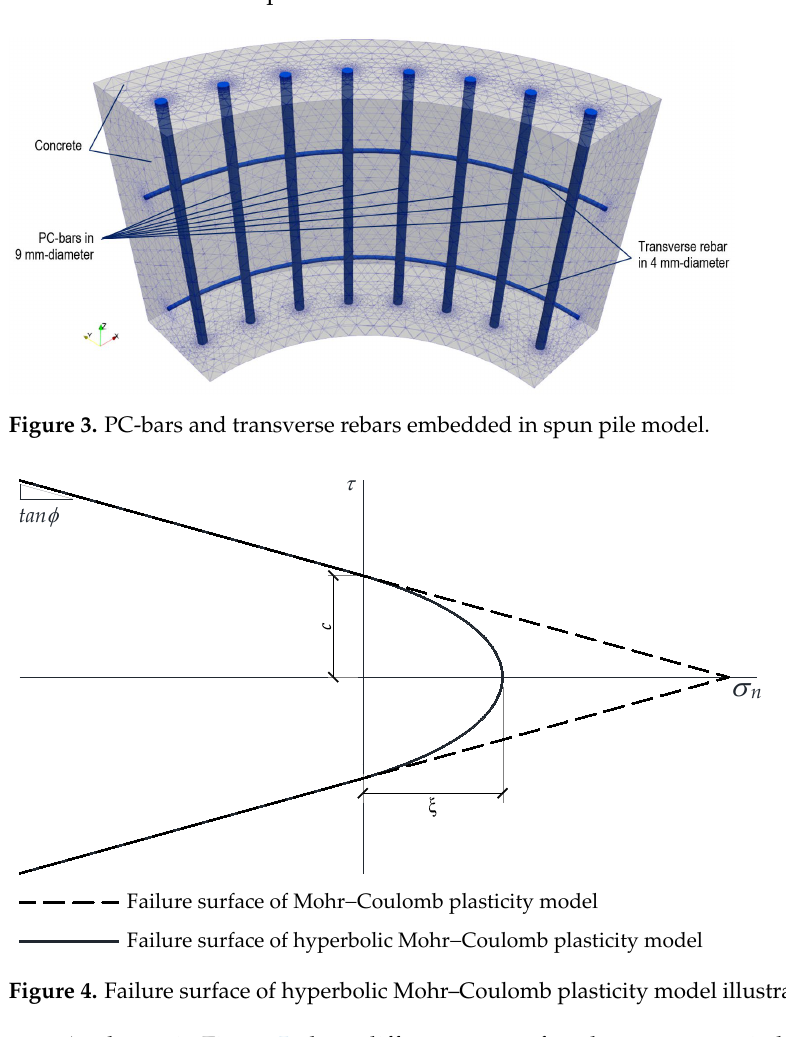
Figure 3. PC-bars and transverse rebars embedded in spun pile model.